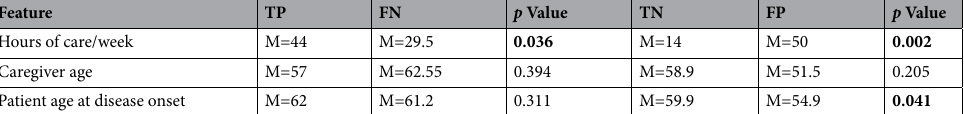
Table 5. Mann–Whitney U test results for comparisons between TP (True Positives or Correct 1) and FN (False Negatives or Incorrect 0), as well as TN (True Negatives or Correct 0) and FP (False Positives or Incorrect 0) of numerical features in the proposed CDSS model. We present the median values (M) that are compared, followed by the p value of the test. The values in bold show statistically significant differences between the two groups, while for the rest we could not reject the null hypothesis.